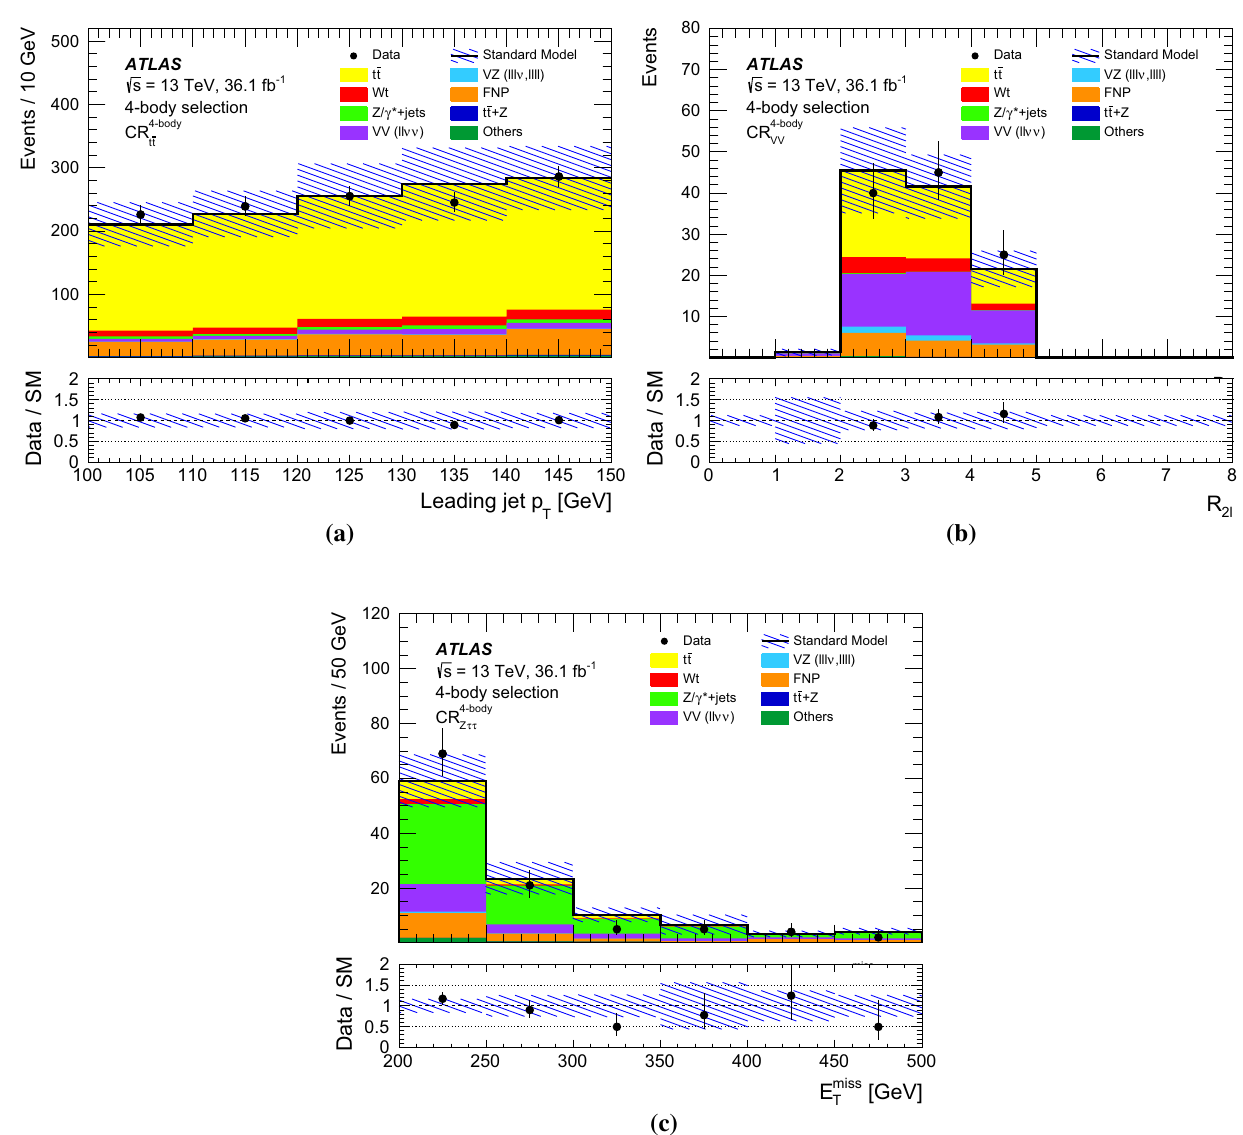
Fig. 4 Four-body selection distributions of the a p T ( j 1 ) in CR 4-body in the background predictions after the fit to the data has been , t ¯ t performed. The counting uncertainty on data is also shown by the b R 2 (cid:3) in CR 4-body and c E miss T in CR 4-body after the background VV Z ττ black error bars. The rightmost bin of each plot includes overflow fit. The contributions from all SM backgrounds are shown as a histogram stack; the hatched bands represent the total uncertainty